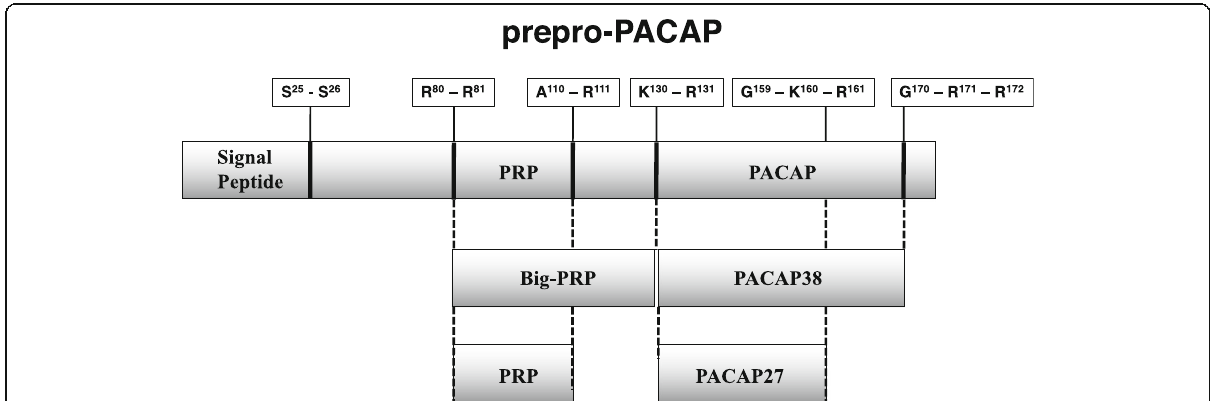
Fig. 2 Structure of human prepro-PACAP. PACAP38 and PACAP27 are produced by alternative processing from the PACAP precursor